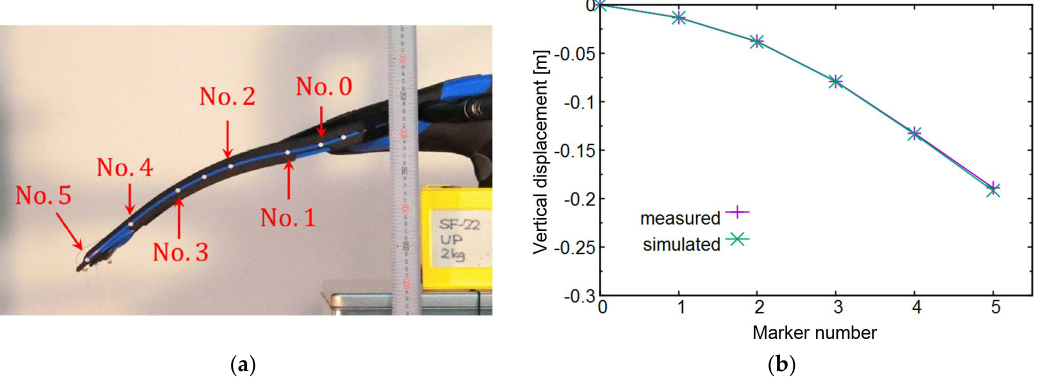
Figure 5. Stationary test to determine the bending stiffness of the fin: ( a ) Experimental setup; ( b ) An example of the results for the experimental and simulated displacements. The weight was 3 kg in this